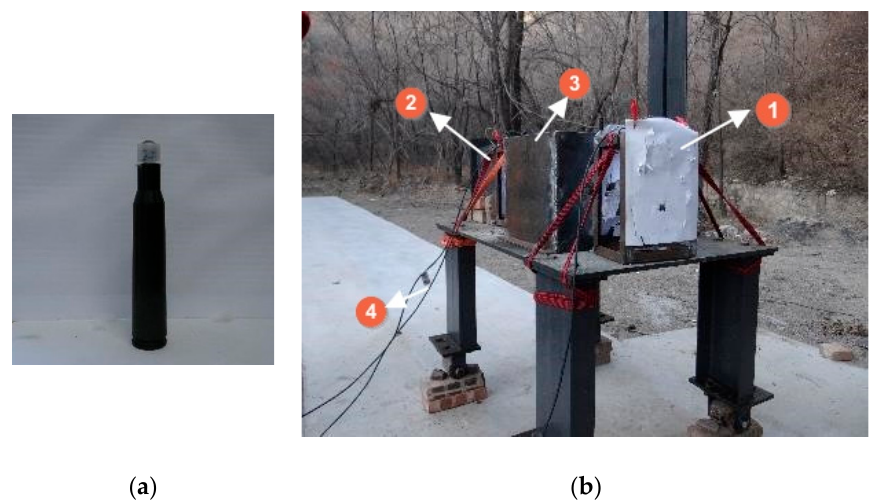
Figure 2. Physical diagram of test device. ( a ) is experimental cartridge (sabot, fragment); ( b ) is the experimental station.